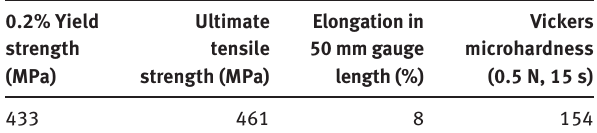
Table 2: Mechanical properties of parent metal.